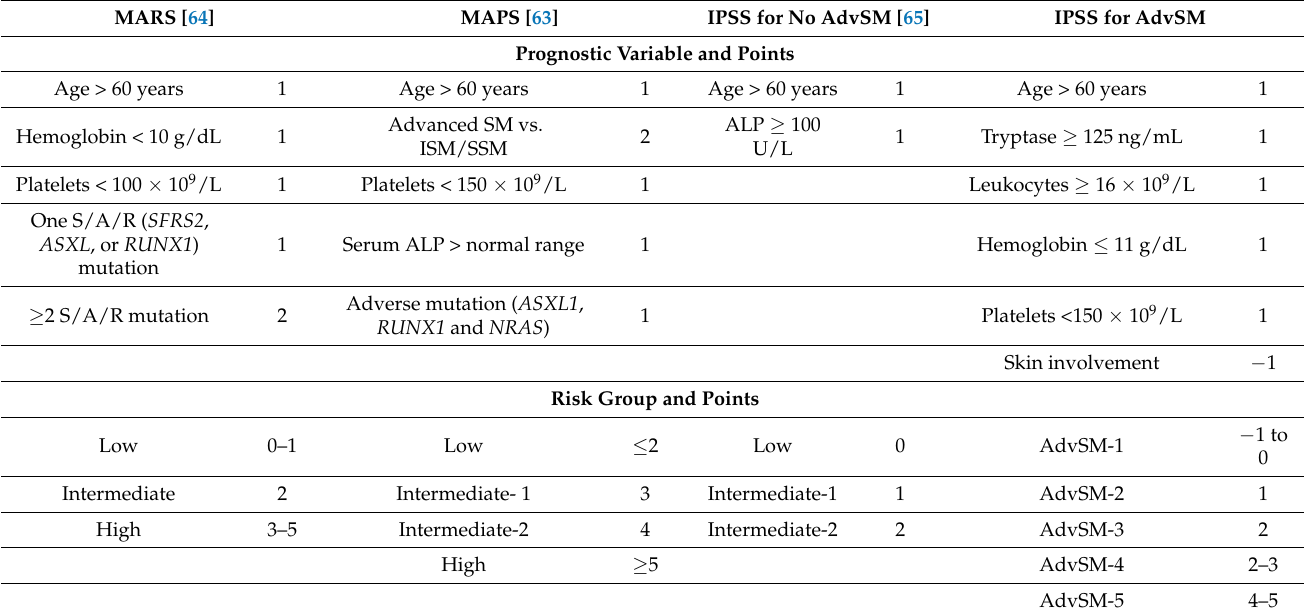
Table 4. Different prognostic score risk stratifications for Systemic Mastocytosis